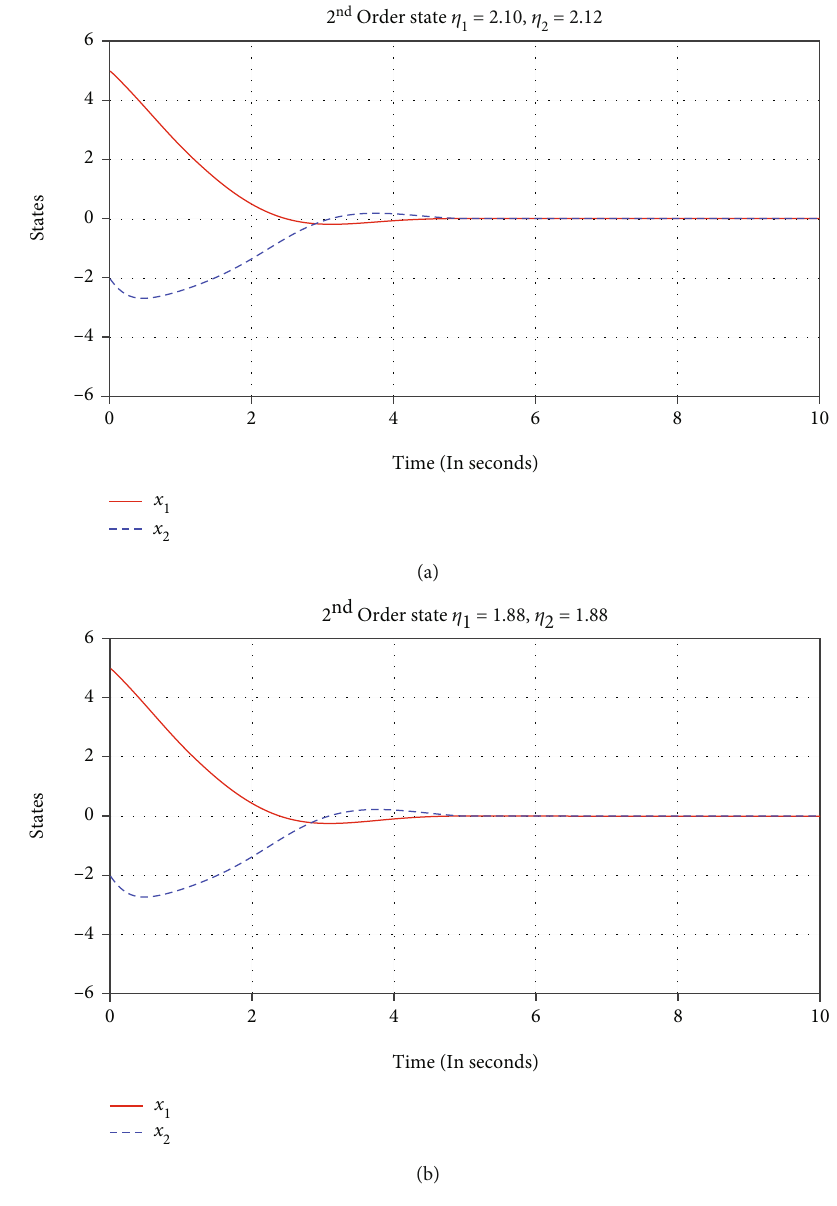
= η = 2 : 12 and (b) η 1 2